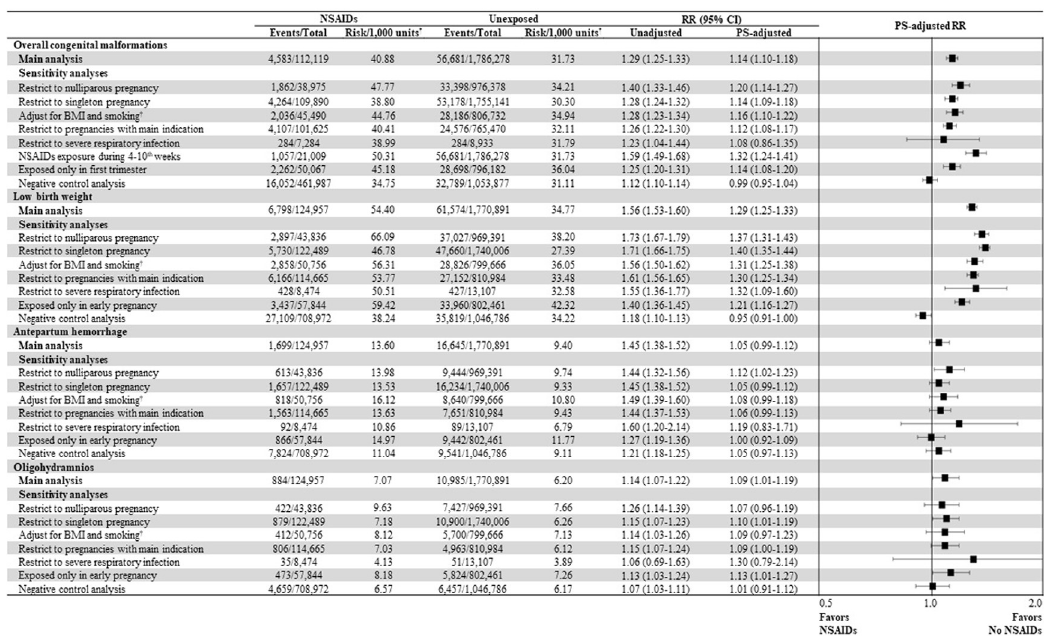
Fig 4. Results of sensitivity analyses for the risks of neonatal and maternal adverse outcomes associated with prenatal NSAID exposure during early pregnancy. CI, confidential interval; NSAID, nonsteroidal anti-inflammatory drug; PS, propensity score; RR, relative risk. † Restrict the study cohort to those who underwent health screening examination for whom information on BMI and smoking was available. � Units: births for outcomes of overall congenital malformations and low birth weights; pregnancies for outcomes of antepartum hemorrhage and